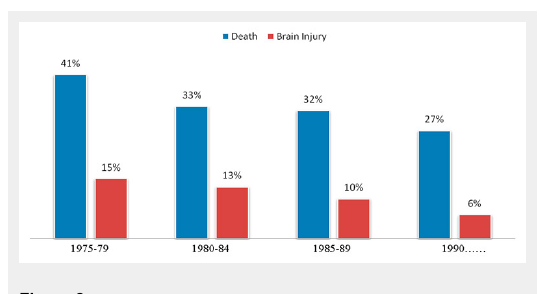
Historical evolution of improvements in anaesthesia-related mortality.